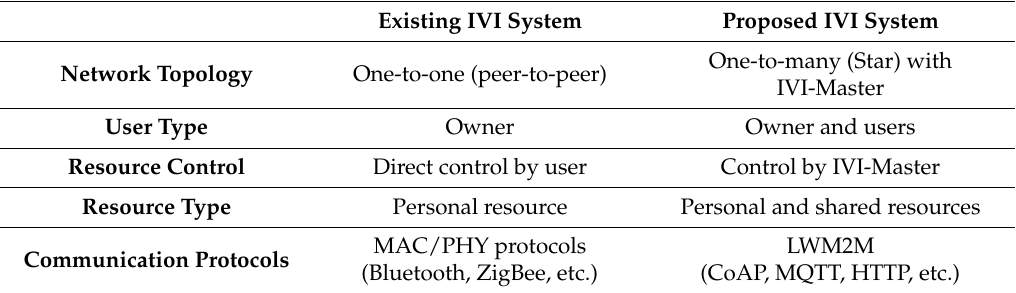
Table 1. Architectural comparison of the existing and proposed IVI systems.